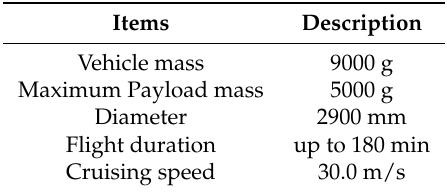
Table 3. The technical specifications of